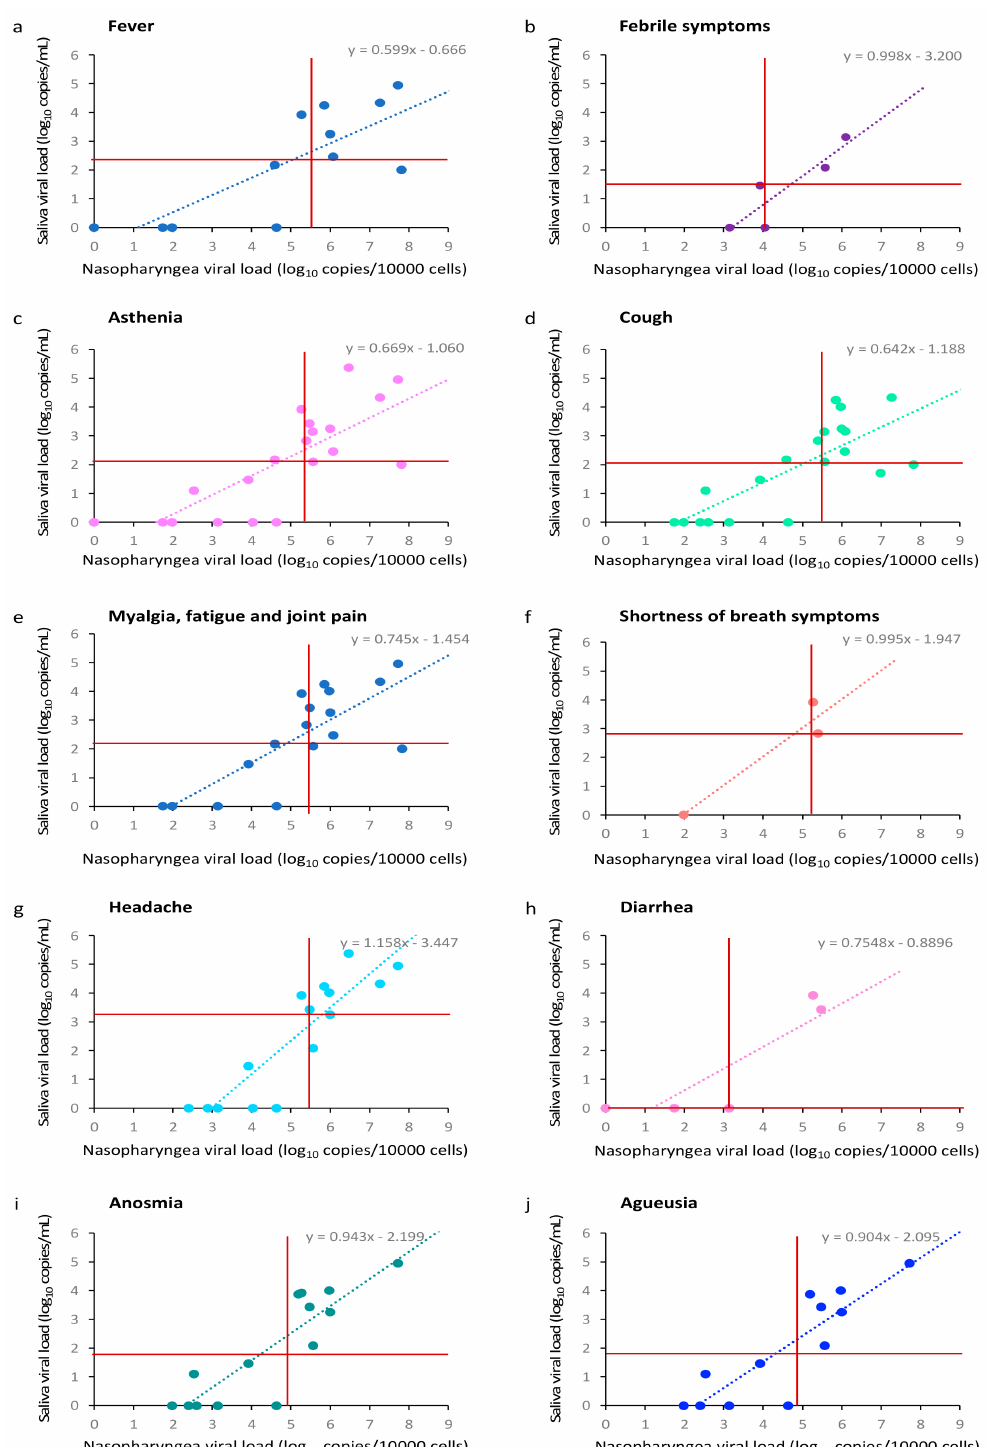
Figure 3. Analysis of SARS-CoV-2 viral load in nasopharyngeal (log 10 copies/10,000 cells) and saliva (log 10 copies/mL) samples according to clinical symptoms. ( a ) SARS-CoV-2 values by testing concordance for fever; ( b ) SARS-CoV-2 values by testing concordance for febrile symptoms; ( c ) SARS-CoV-2 values by testing concordance for asthenia; ( d ) SARS-CoV-2 values by testing concordance for cough; ( e ) SARS-CoV-2 values by testing concordance for myalgia, fatigue, and joint pain; ( f ) SARS-CoV-2 values by testing concordance for headache; ( g ) SARS-CoV-2 values by testing concordance for diarrhea; ( h ) SARS-CoV-2 values by testing concordance for anosmia; ( i ) SARS-CoV-2 values by testing concordance for anosmia; ( j ) SARS-CoV-2 values by testing concordance for agueusia. Red horizontal and vertical lines indicate the